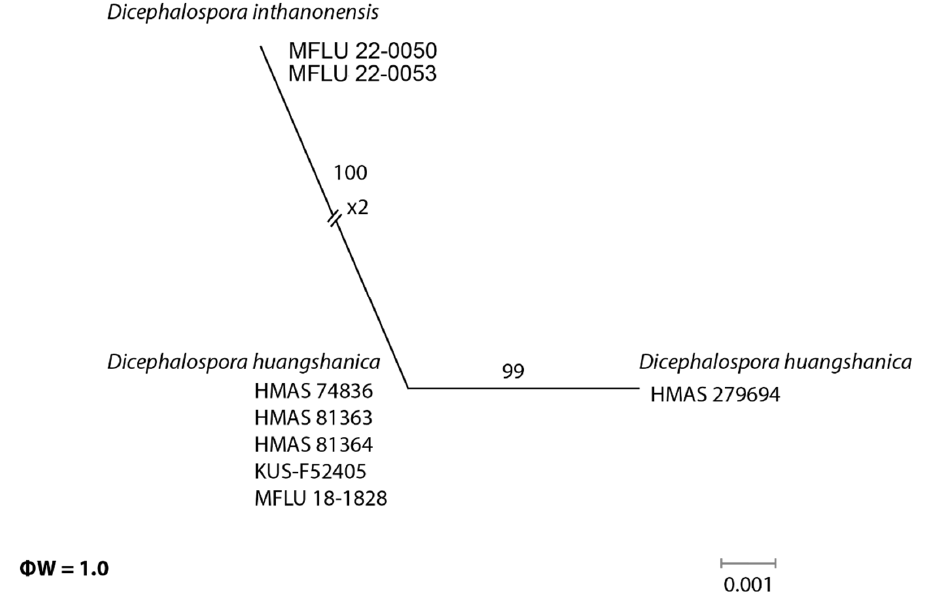
Figure 4. The results of the pairwise homoplasy index (PHI) test for the closely related species of Dicephalospora inthanonensis using both LogDet transformation and splits decomposition. PHI test results ( ф w) < 0.05 indicate significant recombination within the dataset.